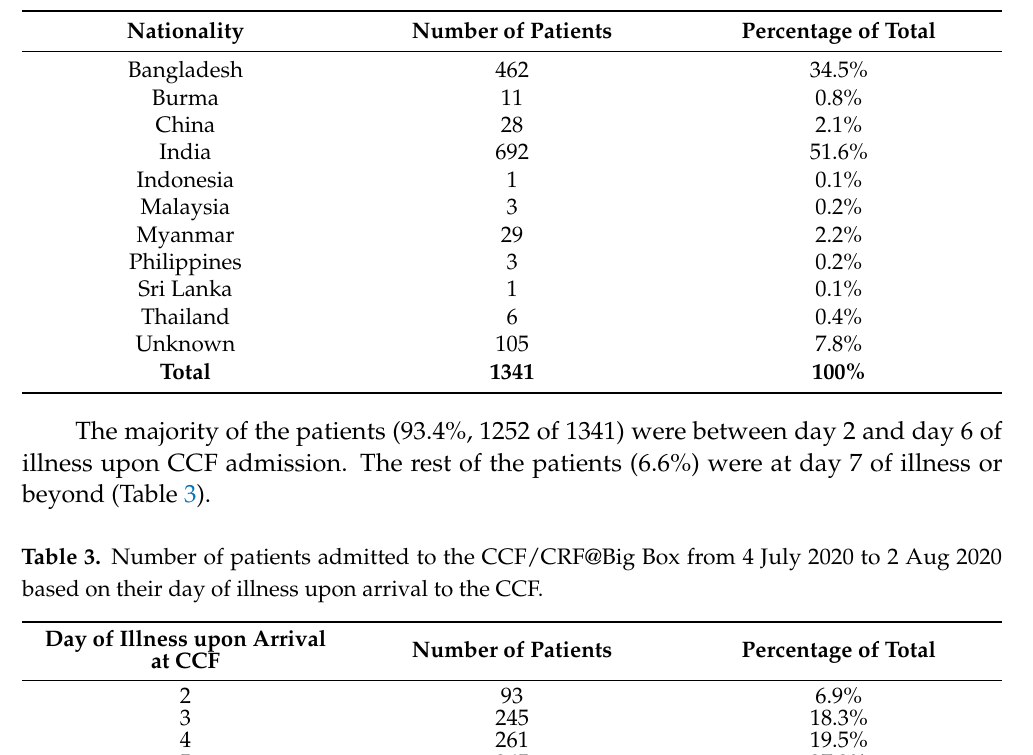
Table 2. Demographics of patients admitted to the CCF/CRF@Big Box from 4 July 2020 to 2 August 2020 (sorted by nationality).